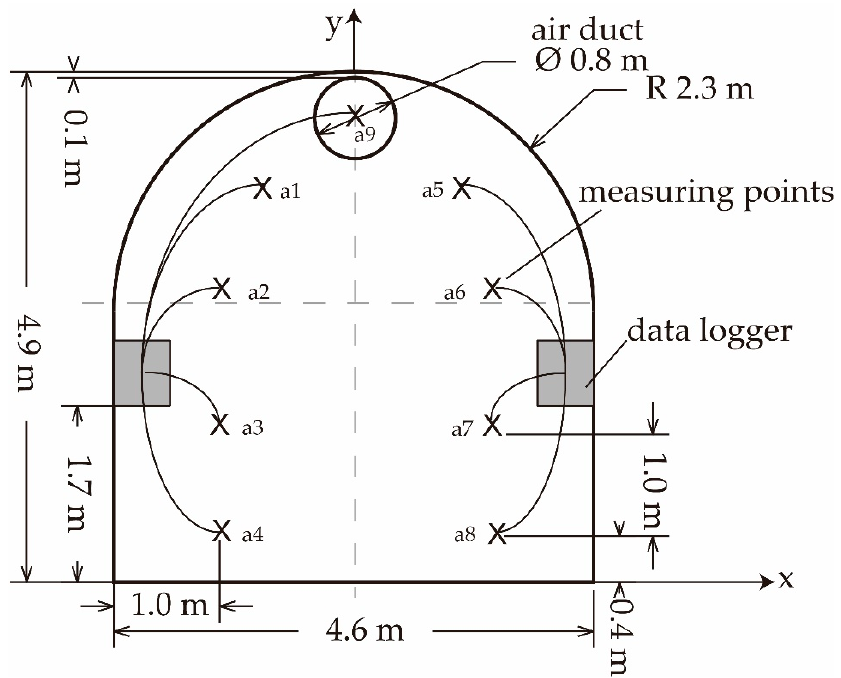
Figure 3. Cross-sectional view of the measuring points.